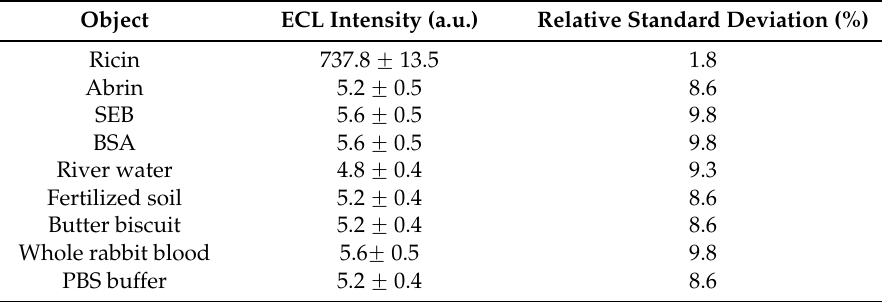
Table 7. Detection specificity of ECL immunosensor ( n = 5).